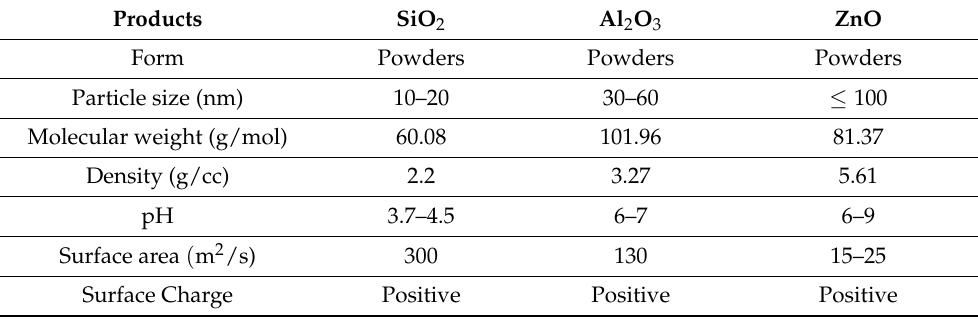
Table 4. Properties of nanoparticles (as per manufacturer).